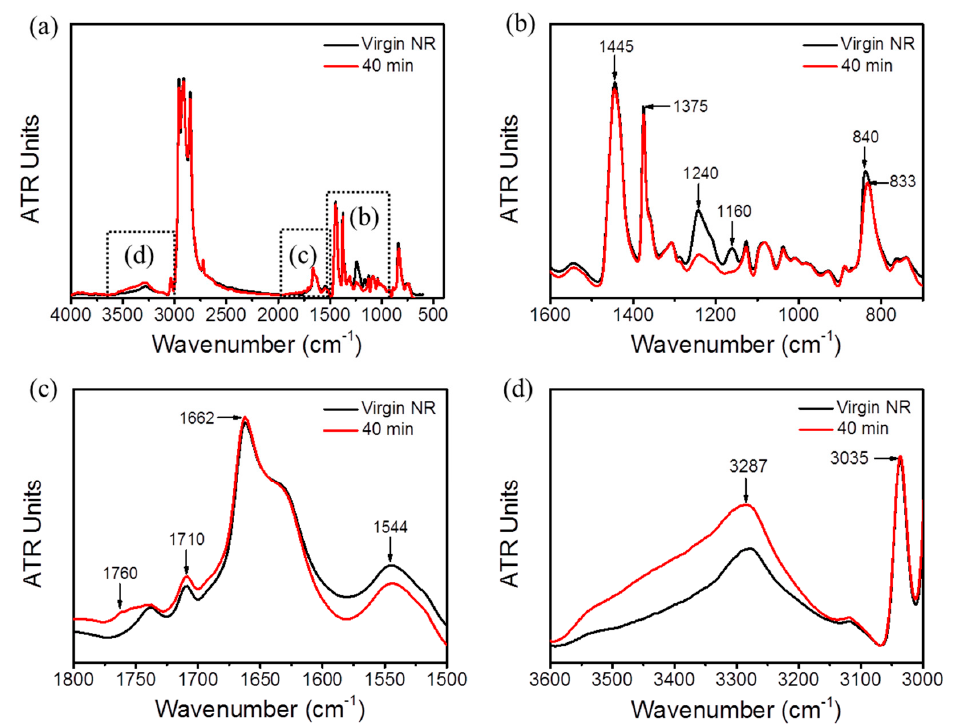
Figure 3. Evolution of vector-normalized FT-IR spectra of virgin NR and masticated natural rubber (mNR) recorded in different domains: ( a ) In the domain 4000–400 cm -1 ; ( b ) In the domain 1600–700 cm -1 ; ( c ) In the domain 1800–1500 cm -1 ; ( d ) In the domain 3600–3000 cm -1 .